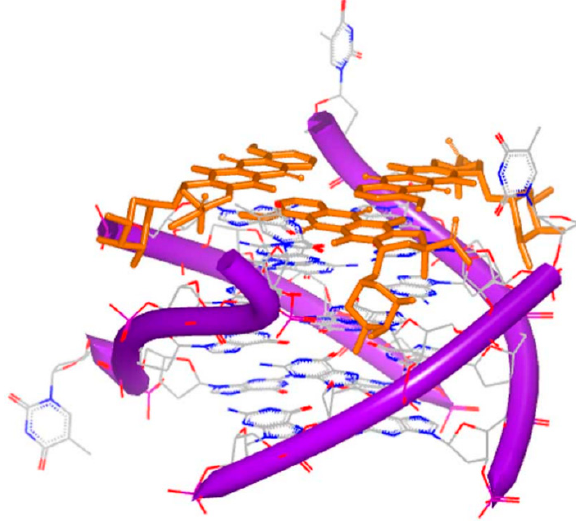
Figure 17. Crystal complex of a DNA quadruplex with daunomycin (PDB code: 1O0K). The orange structure represents the small molecule; the purple structure represents the backbone of nucleic acid; the blue and red atoms in the molecule represent nitrogen and oxygen atoms, respectively.